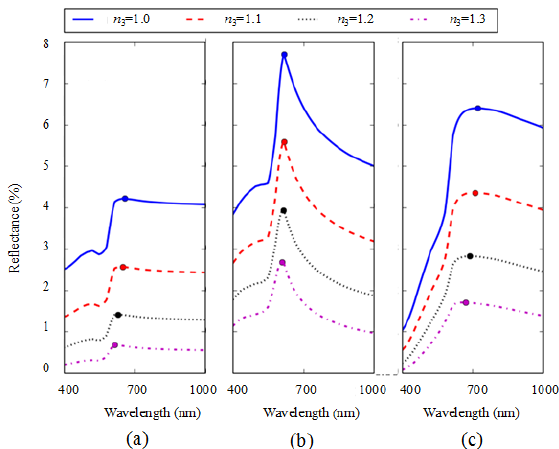
Fig. 6 Calculated reflection spectrum for Cu NPs in polymer with f =0.05 at the film thicknesses of (a) 20 nm, (b) 80 nm, and (c) 140 nm.